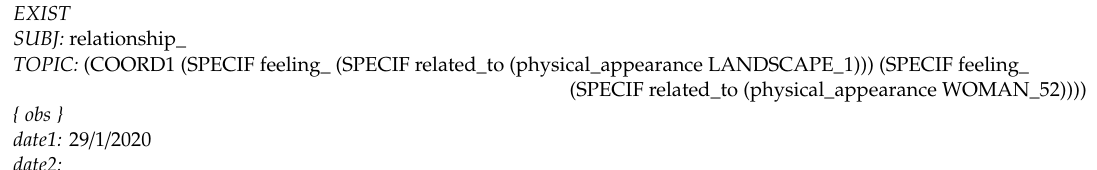
Table 5. A search pattern about the possible relationships between the landscape and the portrait.